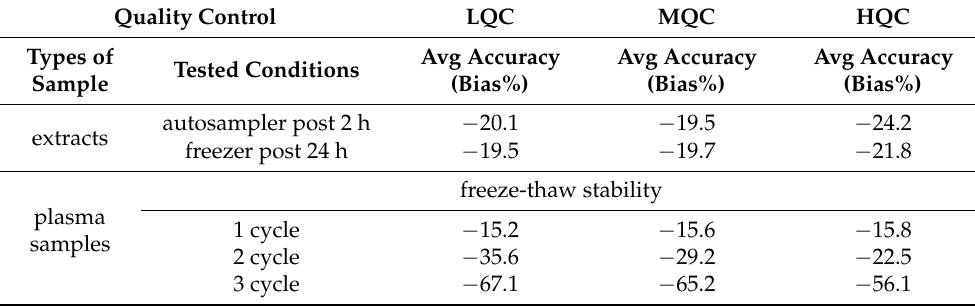
Table 7. Stability of MRP at different storage conditions. In our study, we tested both the extracts and the plasma samples (according to our routine needs).